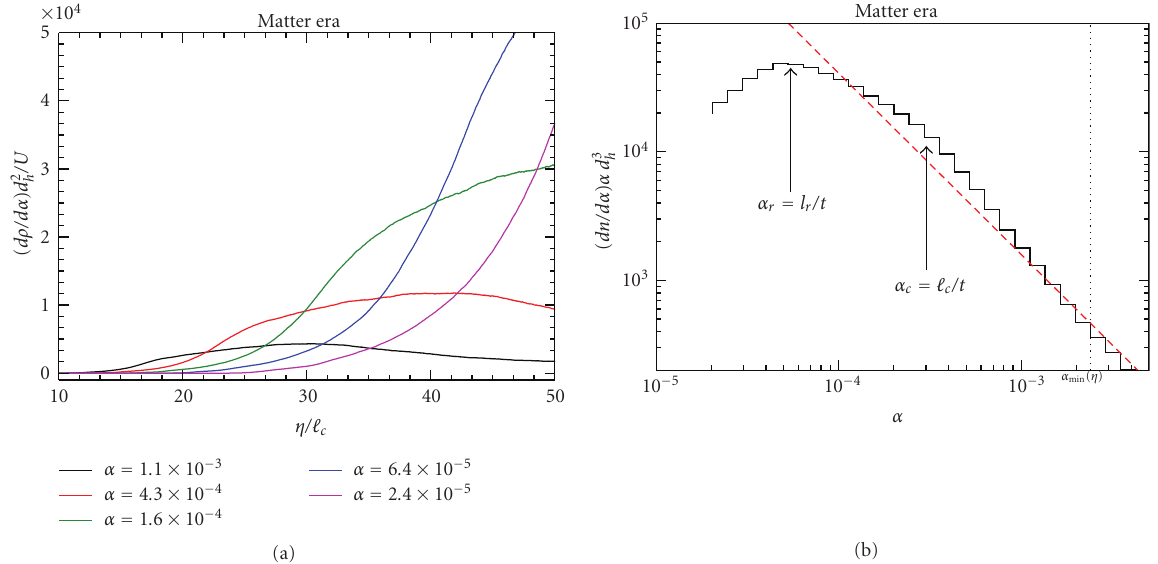
Figure 10: Loop energy density distribution with respect of the conformal time for the smallest loops. By the end of the numerical simulation, these loops have not yet reached their scaling behaviour (a). (b) is the corresponding loop number density distribution at the end of the simulation ( η/(cid:15) c = 50). Compared to the asymptotic scaling power law (red dashed), the loops in the relaxation regime are preferentially produced at fixed physical lengths given by the initial correlations present in the VV